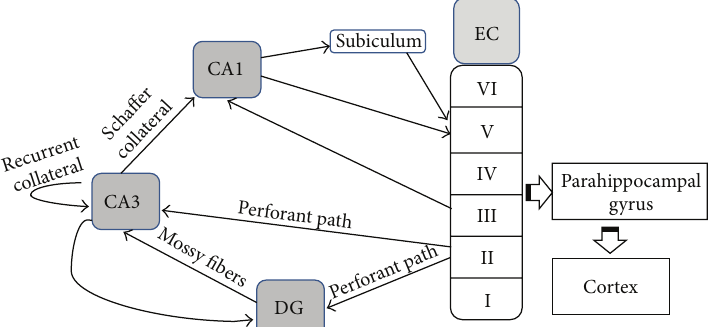
Figure 1: Anatomy of hippocampal network. The diagram illustrates the monosynaptic and the trisynaptic pathways in the hippocampus. The monosynaptic pathway consists of a direct projection from the EC to CA1 or CA3, whereas the trisynaptic pathway consists of sequential projections from EC to DG, CA3, and then to CA1. EC: entorhinal cortex; DG: dentate gyrus; CA: cornu